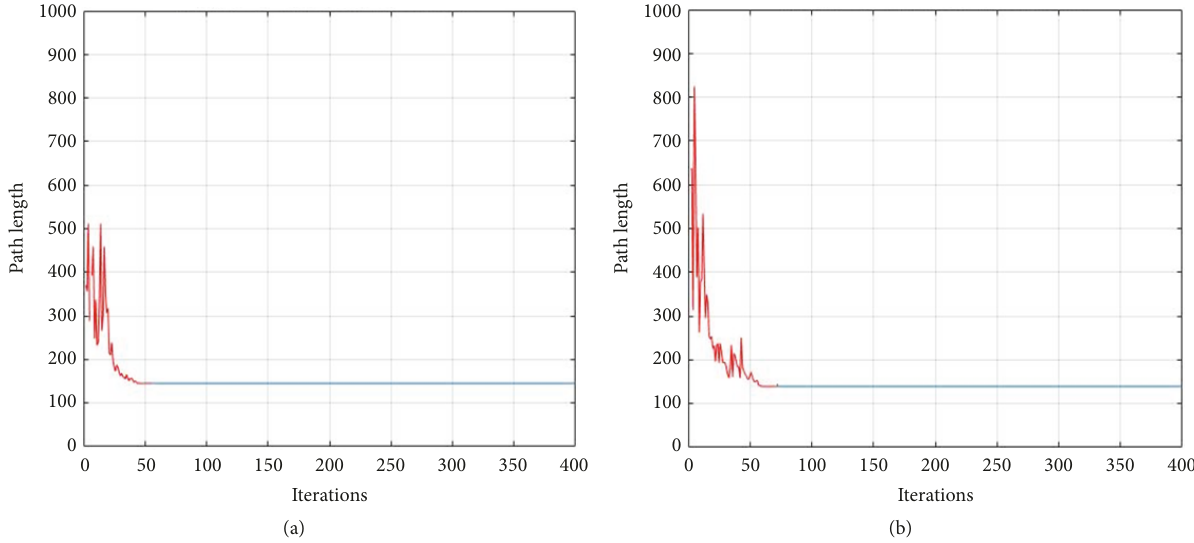
Figure 7: The optimal path length with the increase of iterations in another environment. There are both static and mobile threats in (a) and only mobile threats in